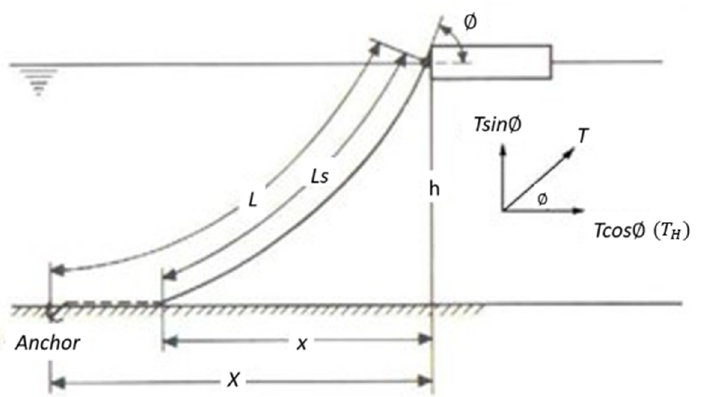
Figure 4. Catenary mooring arrangement.